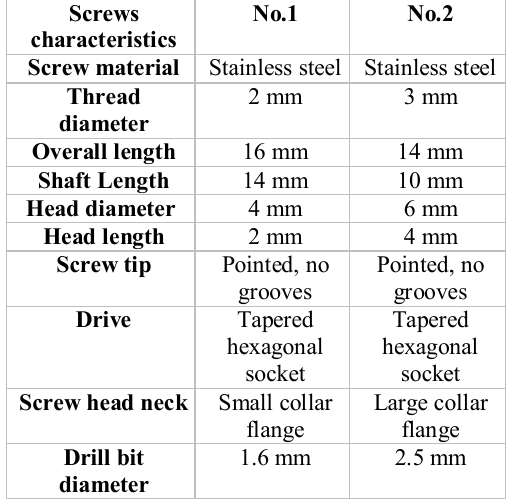
Table 1: Characteristic features of the screws